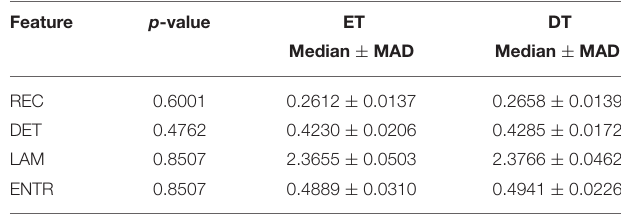
TABLE 1 | Statistical comparison between easy task (ET) and difficult tasks (DT).